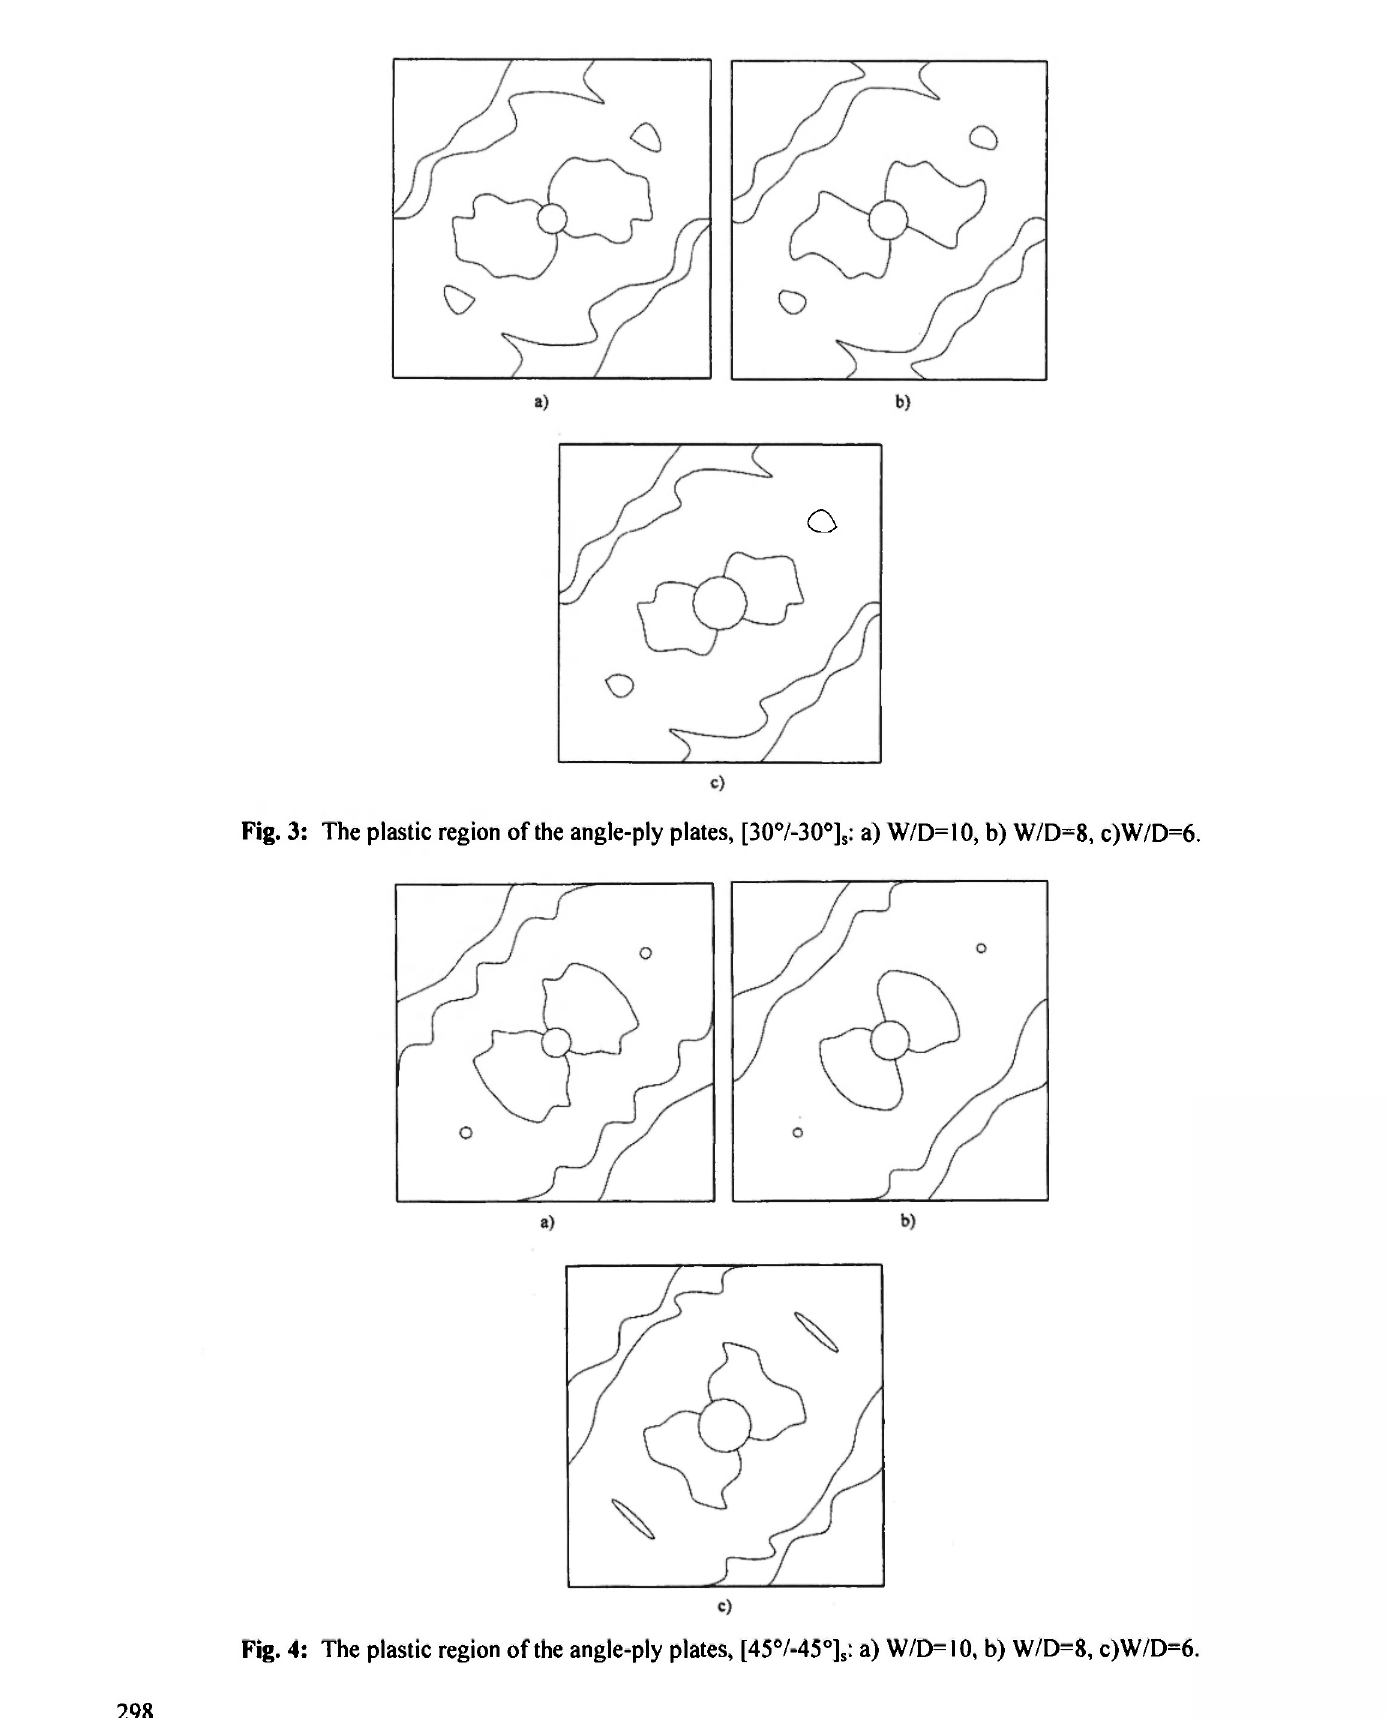
Fig. 4: The plastic region of the angle-ply plates, [45°/-45°] s : a) W/D=I0, b) W/D=8,